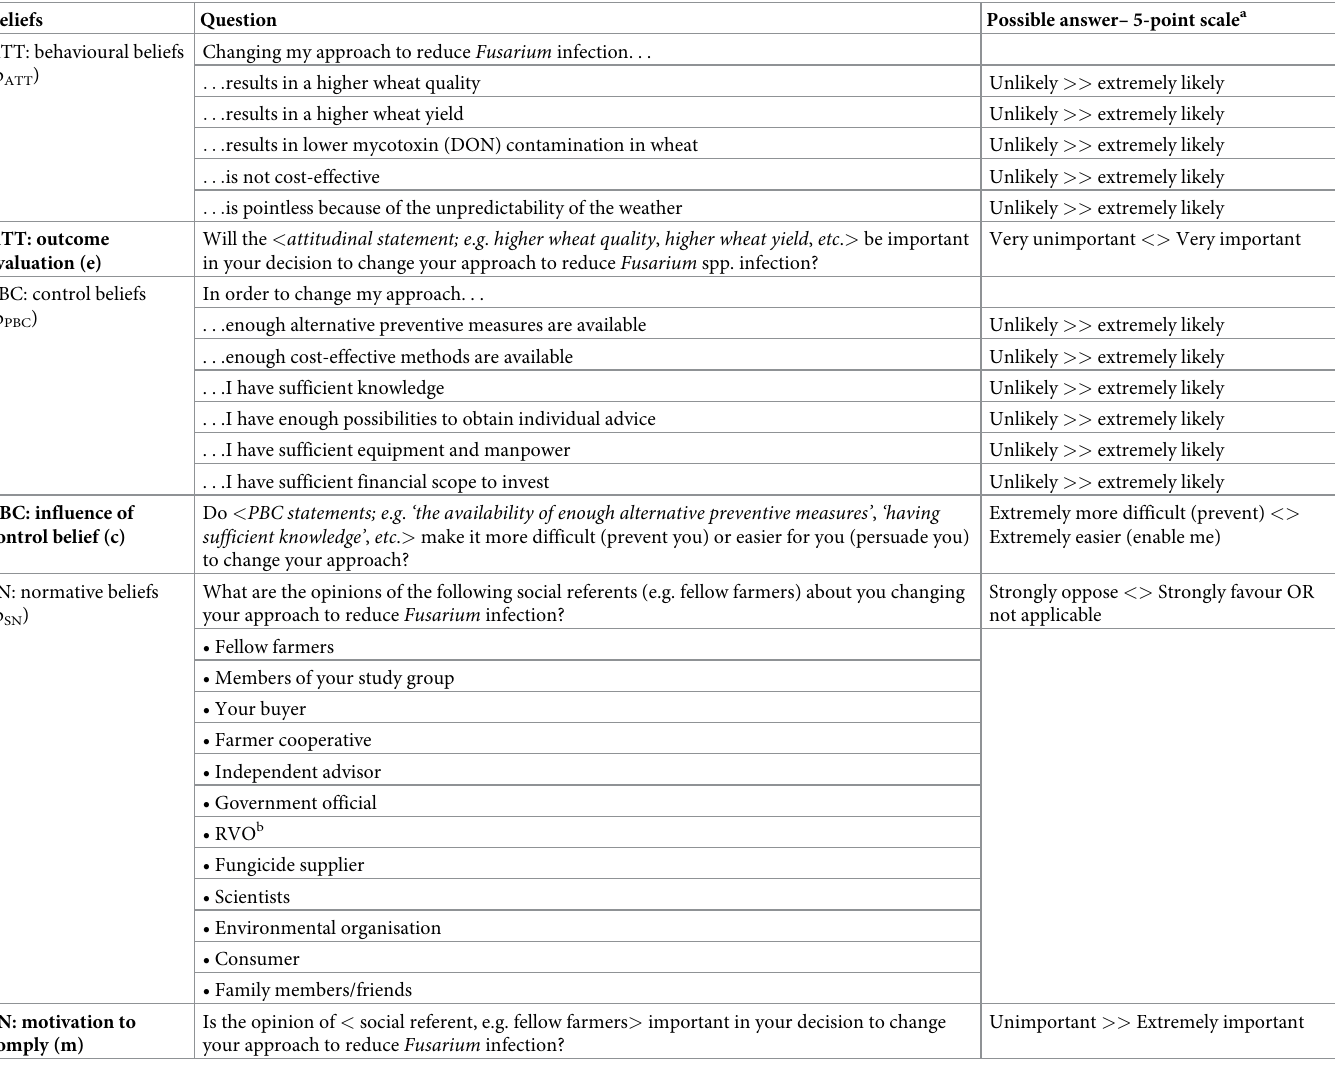
Table 2. Theory of planned behaviour (TPB) beliefs questionnaire questions and answer formats for attitude (ATT) beliefs, perceived behavioural control (PBC) beliefs, and social norm (SN) beliefs. Beliefs Question Possible answer– 5-point scale a ATT: behavioural beliefs Changing my approach to reduce Fusarium infection. . (b ATT )